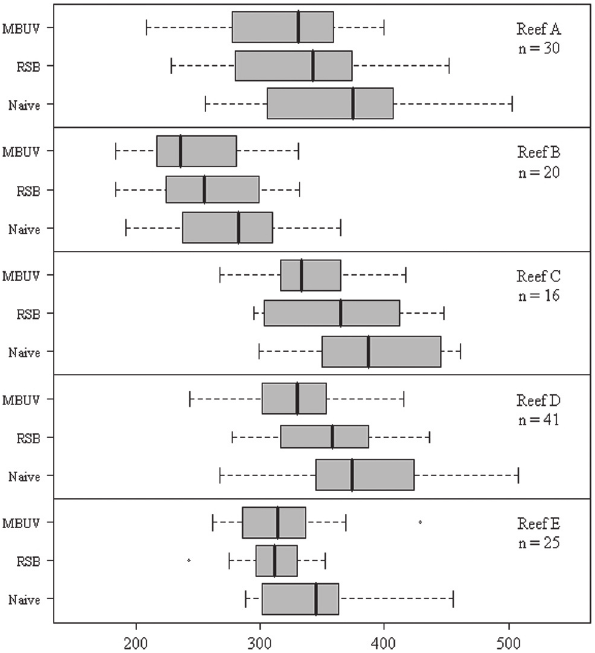
Fig. 4. Boxplots showing the length distributions (mm) for Acanthistius patachonicus in five Submarine Parks within Golfo Nuevo, estimated by the naive ( n = 132), Reference scale at the bait level (RSB) ( n = 98) and Mirrored baited underwater video system (MBUV) ( n = 132) methods. The numbers of fish measured with the MBUV in each reef are indicated, and the widths of the boxes within each reef are proportional to those numbers. The x-axis was truncated to avoid loss of